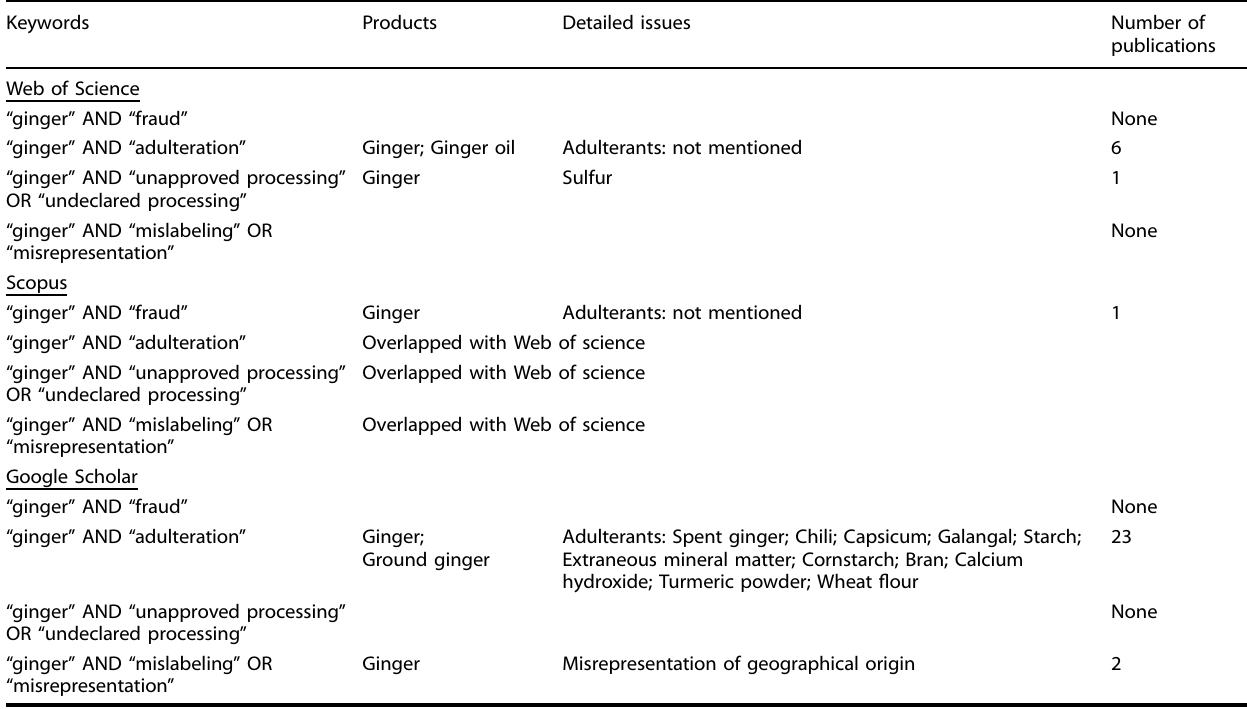
Table 4. The search results of ginger fraud from the